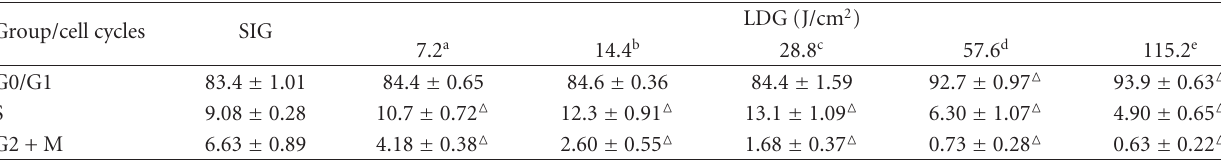
Table 2: E ff ects of low-dose UVA on fibroblast cell cycle ( x ± S %, n =